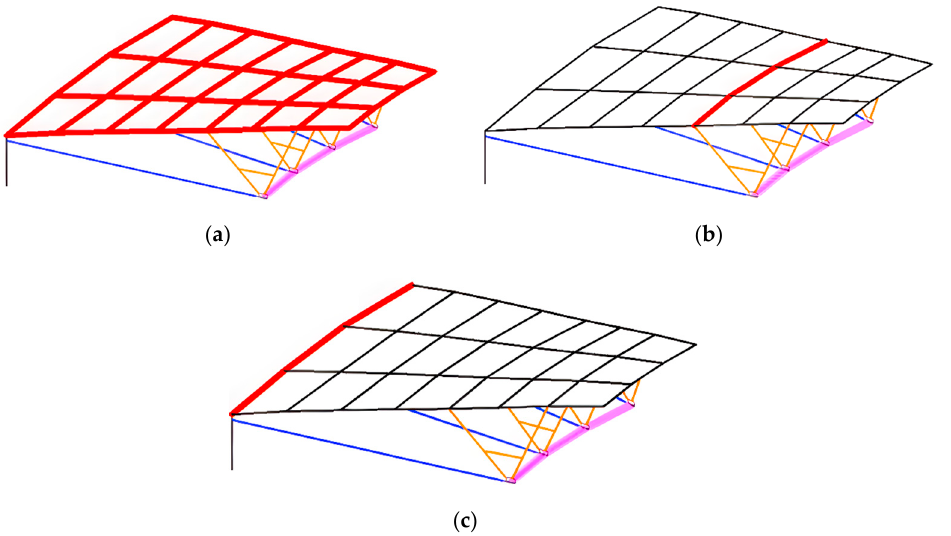
Figure 1. Types of cable supported grid structures: ( a ) upper reticulated shell, ( b ) outer compression ring, and ( c ) inner compression ring balancing radial cable force.